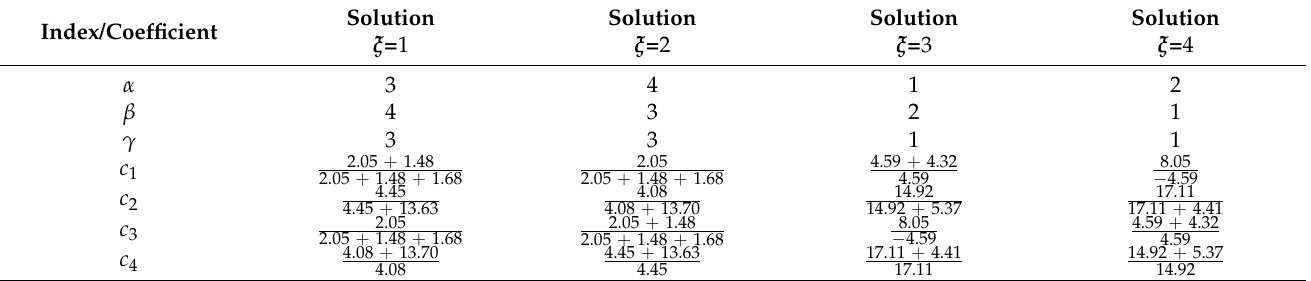
Table 2. The solutions’ ( ξ ) associated indexes ( α , β , and γ ) and coefficient values ( c 1 , c 2 , c 3 , and c 4 ; also see Figure